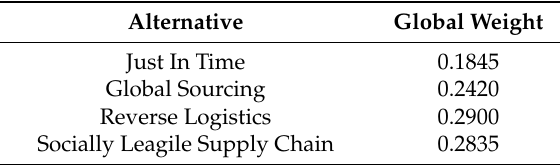
Table 7. Global weight for alternatives obtained from AHP model.